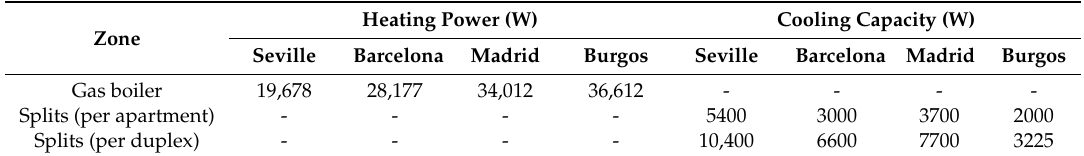
Table 3. System A nominal capacity.